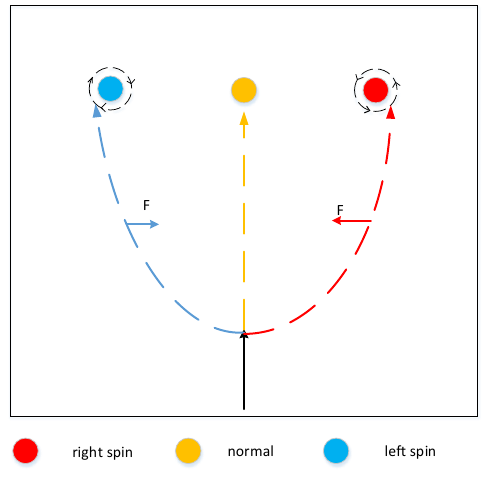
Figure 15. The difference in the placement of the ball with side